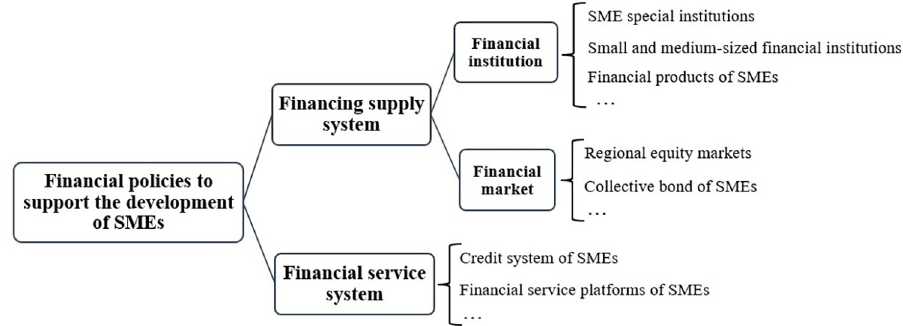
Fig 1. Framework of financial policies that support the development of SMEs. (See S2 Appendix for further details).